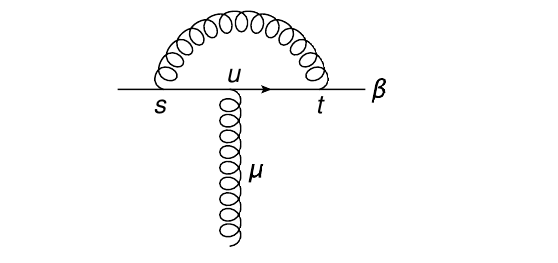
Figure 20 . Diagram used for the calculation of the vertex counterterm, where β is the 4-velocity of the Wilson line, and µ the Lorentz index of the emitted